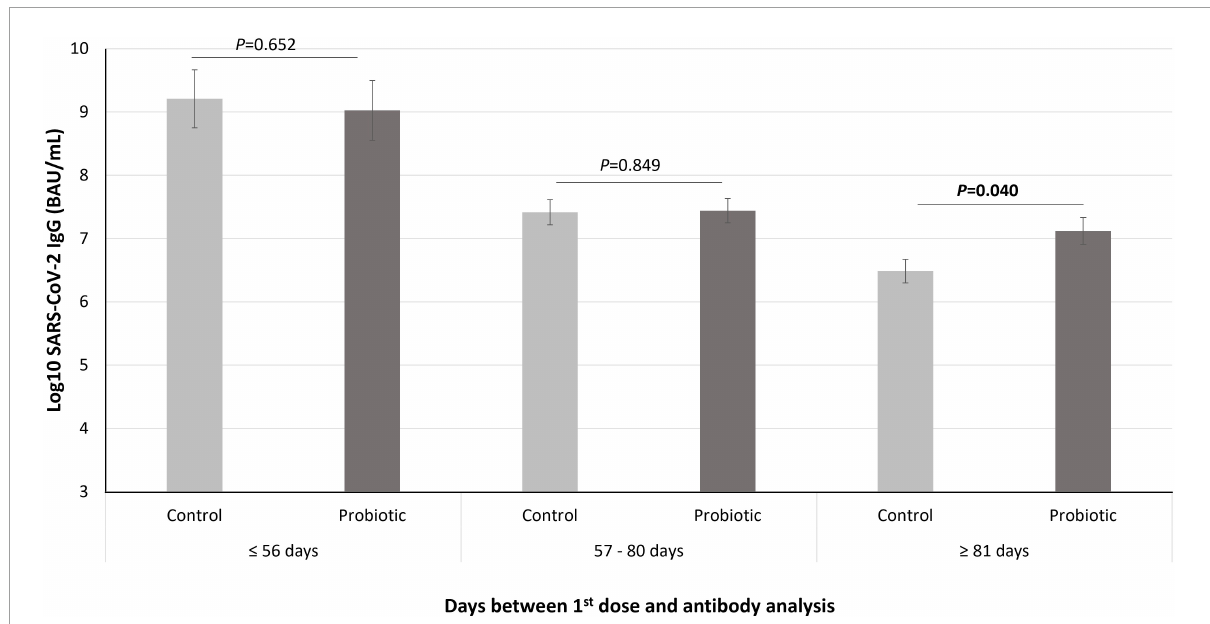
FIGURE2 Levels of SARS-CoV-2 IgG (represented in Log10 of BAU/mL) in the subjects that received the COVID-19 vaccine during intervention ( n = 85) divided into tertiles according to the days between the first dose and the antibody analysis. Data are represented as mean (bars) and SE (vertical lines). P value indicated differences between probiotic group (dark gray bars) and control (light gray bars) groups (univariate models adjusted by age, sex, age, type of vaccine, and start of the